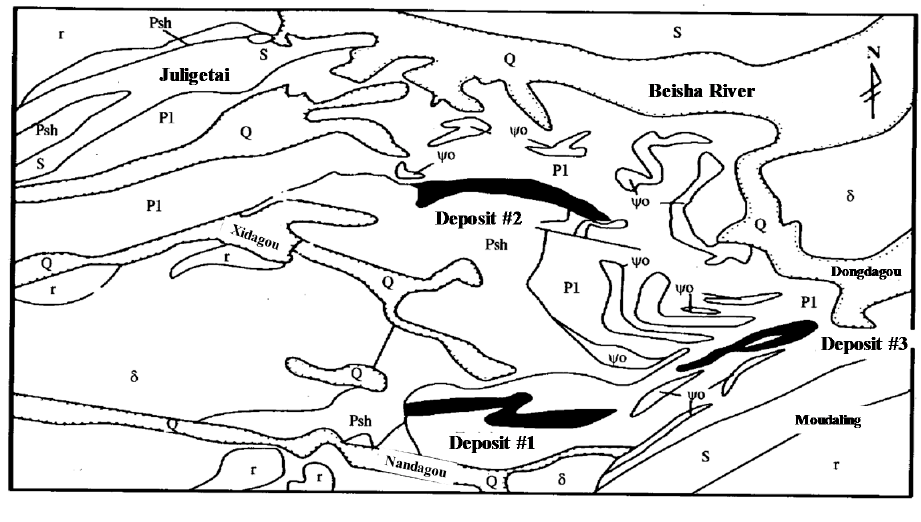
Figure 4. Geological map of the Huogeqi Copper Mine.